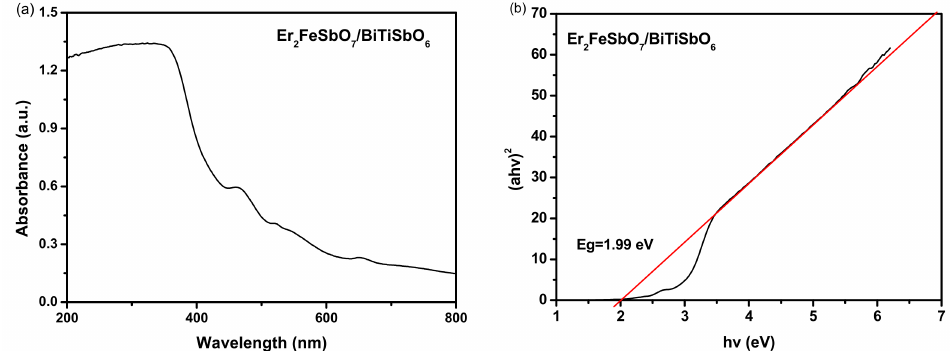
Figure 4. ( a ) UV-Vis diffuse reflectance spectra of Er 2 FeSbO 7 /BiTiSbO 6 heterojunction; ( b ) plot of ( α h ν ) 1/2 versus h ν for Er 2 FeSbO 7 /BiTiSbO 6